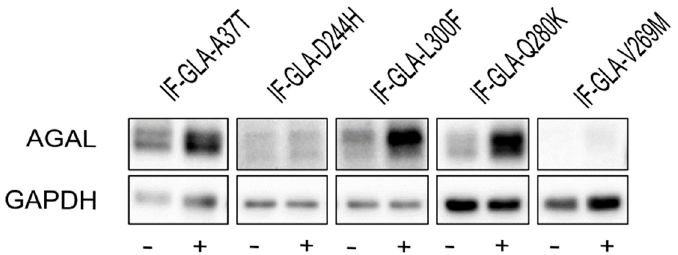
Figure 2. Curcumin treatment increased AGAL. IF-GLA and IF-GLA-MUTs were treated with 20 μ M curcumin for 48 h. AGAL was visualized via immunoblotting on cell protein extracts. The figure shows IF-GLA-MUTs treated with (+) or without ( − ) 20 µ M curcumin. We also explored the potential of curcumin as a PC enhancer; i.e., a molecule able to strengthen the chaperoning effect of PCs. Cells were treated for 48 h with 10 µ M DGJ either alone or in combination with 20 µ M curcumin, and the protein extracts were analyzed. Figure 3 shows that the presence of curcumin improved AGAL stabilization induced by DGJ in four out of the five tested mutants (L300F, D244H, Q280K, and V269M) in a fold-change range of 1.1 (IF-GLA-V269M) to 2.3 (IF-GLA-L300F). As shown in Figure 4, immunoblots reflected the results.